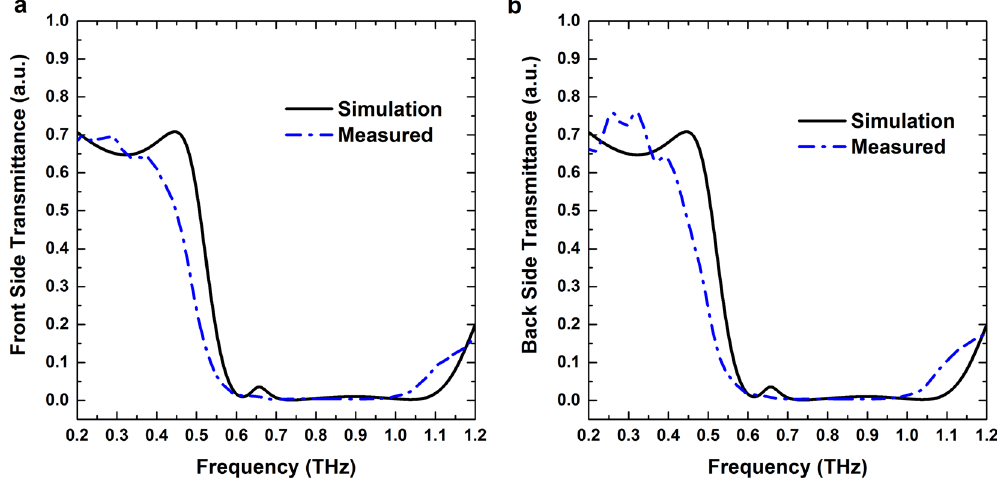
Figure 2. Simulated and measured transmission spectra for ( a ) Front side and ( b ) Back side